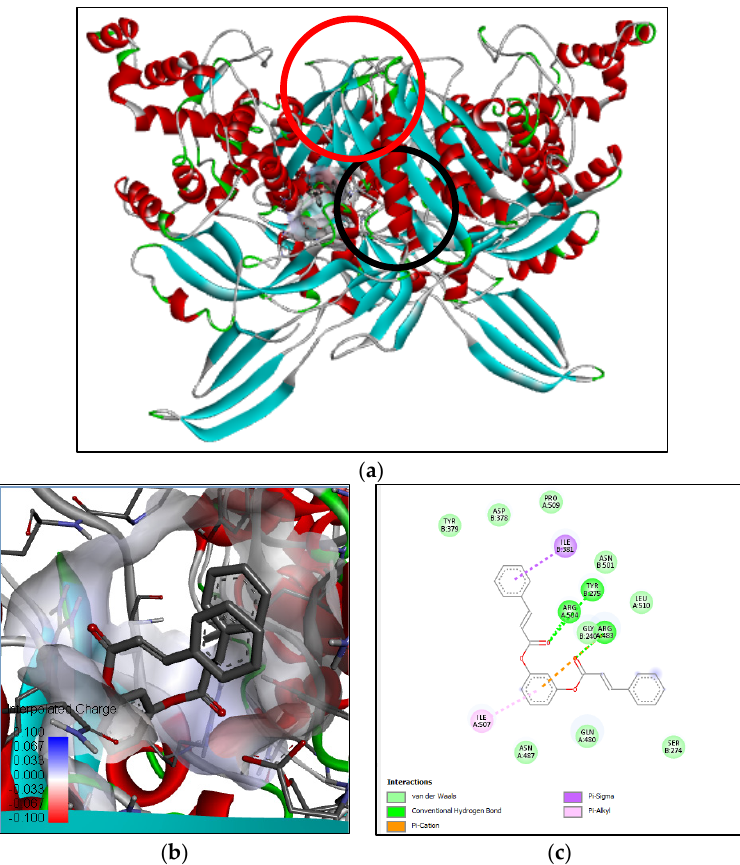
Figure 7. Binding interaction of 1,3-phenylene, bis(3-phenylpropenoate) compound with antibacterial target protein (3VSL) based on the binding energy generated by PyRx program: ( a ) a close-up view of ligand binding on 3VSL (binding sites of the native ligand and docked ligand are indicated by red and black circles, respectively); ( b ) 3D diagram of ligand–protein binding pose; ( c ) 2D illustration of ligand–protein